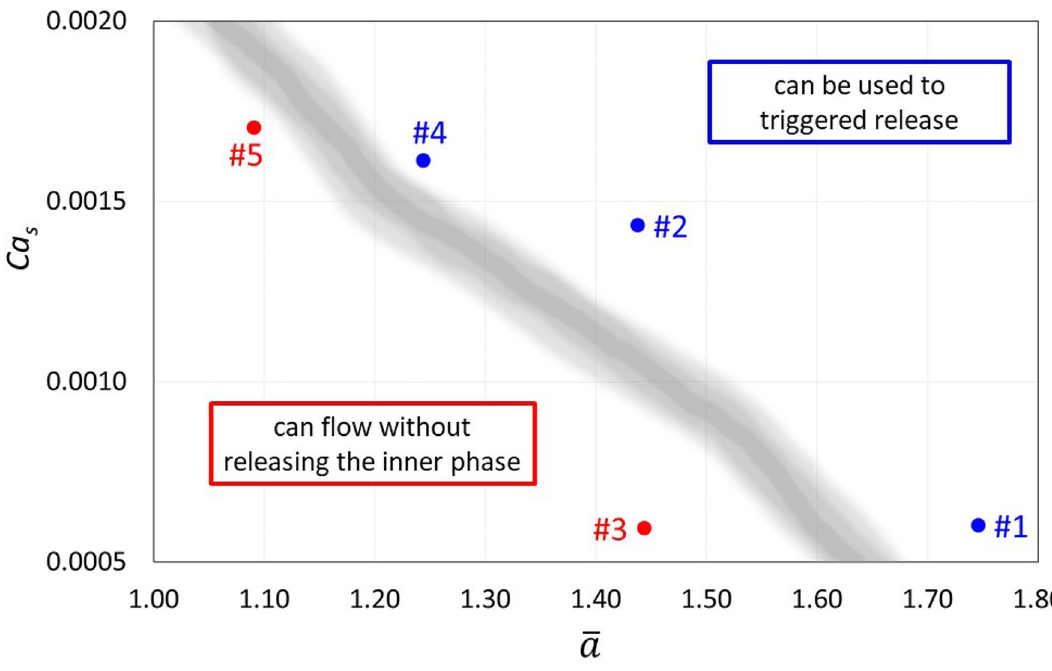
Figure 9. Map of state of capsule after flowing through the constriction as a function of dimensionless capsule diameter a and surface capillary number Ca s : (red circle) reversible deformation and (blue circle)